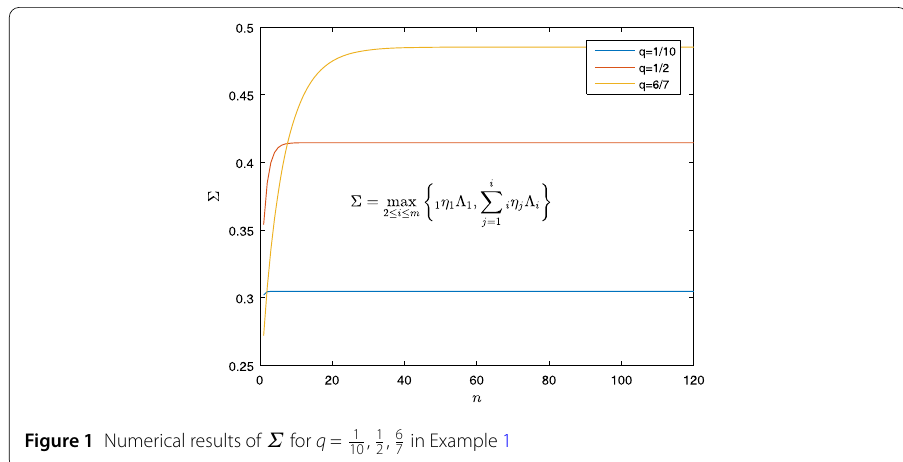
, 1 , 6 in Example 10 2 7